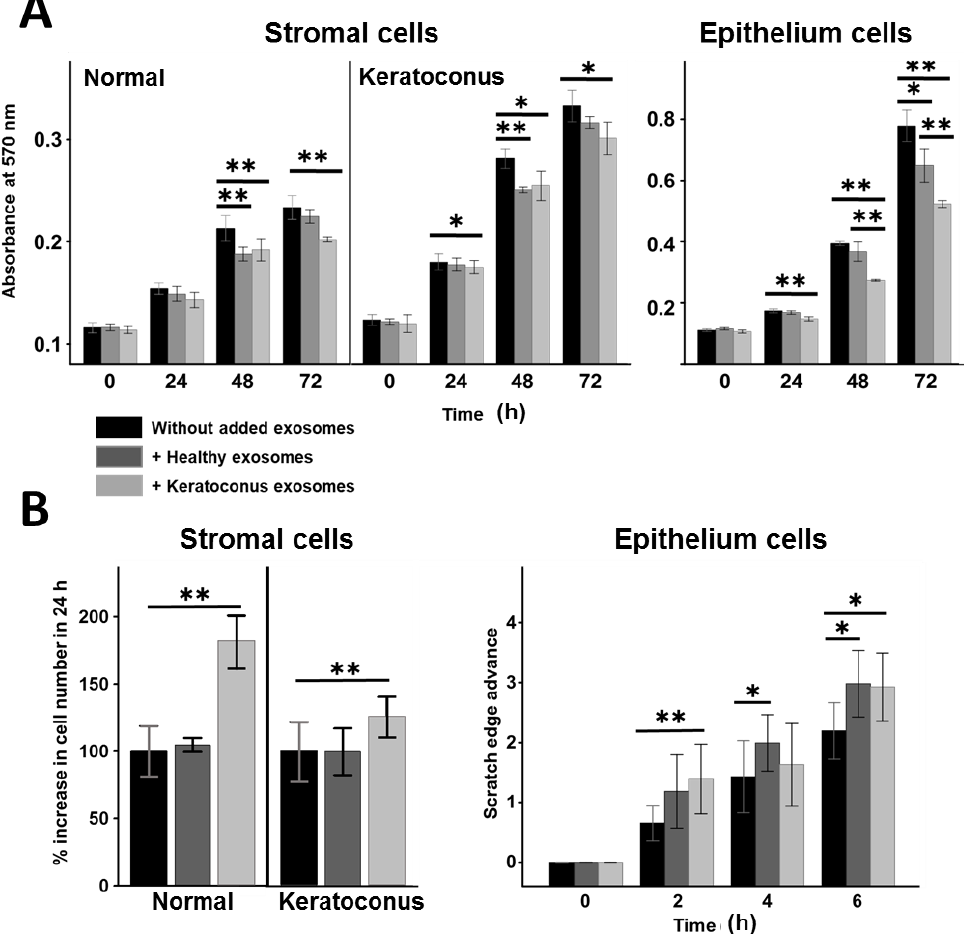
Figure 8. Influence of pathological exosomes on cell behavior compared to that produced by healthy cells. ( A ) Influence of exosomes on cell proliferation. ( B ) Influence of exosomes on cell migration. Values display the mean of 3 independent experiments, and the spreads represent standard deviation. Values that show significant differences (Student’s t test) are highlighted: *: p < 0.05, **: p < 0.001.